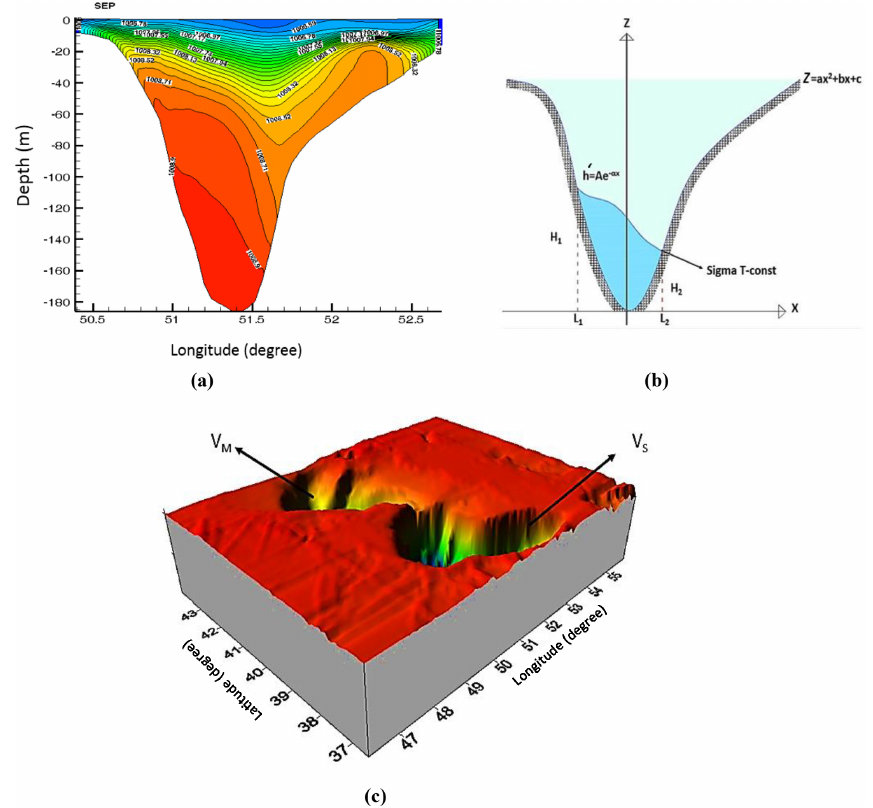
Figure 15. (a) Typical density fields along transect I for September from which we calculate the flow rates. (b) The scheme of the topography with a typical isopycnal and model parameters. (c) The model bathymetry used to calculate the volumes of the middle ( V M ) and southern ( V S ) basins. The Surfer software is used to plot and calculate V M and V S using GEBCO data with a 0 . 5 ◦ × 0 . 5 ◦ resolution. Table 4. Flushing times of the middle ( T M ) and the southern ( T S ) basins (using an annual average volume flow rate, Q V , below three levels based on Eq.